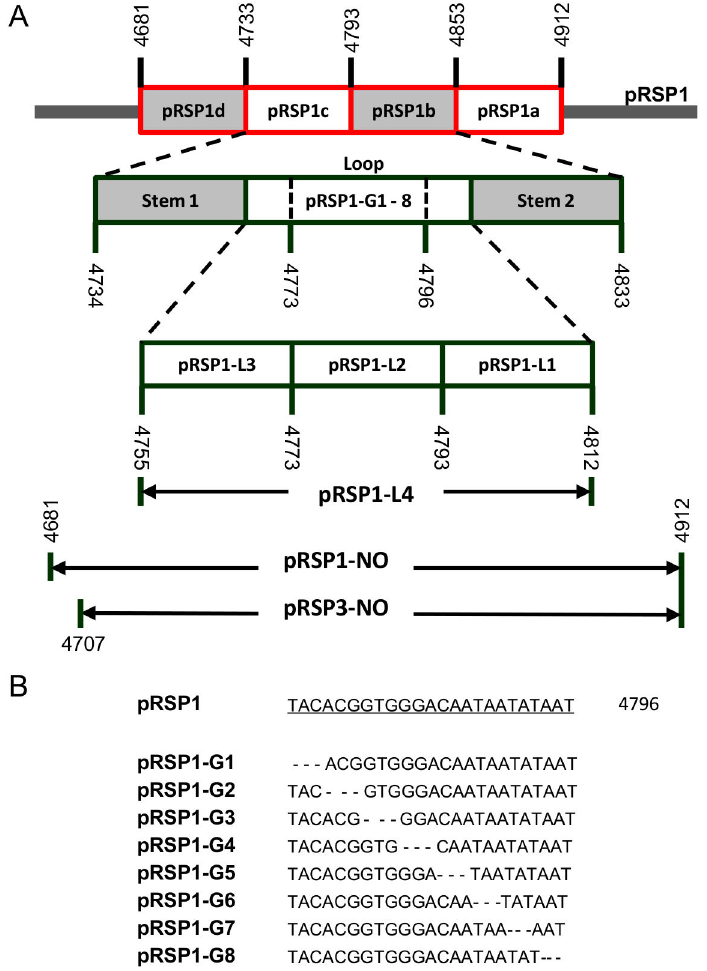
Figure 2. Strategy of mapping pRN1 putative origin of replication (double red arrow in Figure 1). (A) Various deletions were made within the ‘putative ori’ in pRSP1 to generate plasmids highlighted in each rectangular box to determine the role of the deleted regions in pRN1 replication. We constructed pRSP1-NO and pRSP3-NO by deleting 232-bp and 207-bp, respectively, from the putative origin. (B) Three-nucleotide deletion mutants of pRSP1 were constructed to map the loop of stem-loop structure within pRN1 origin. Each construct was transformed into S. acidocaldarius and scored for production of LacS expressing transformants. doi: